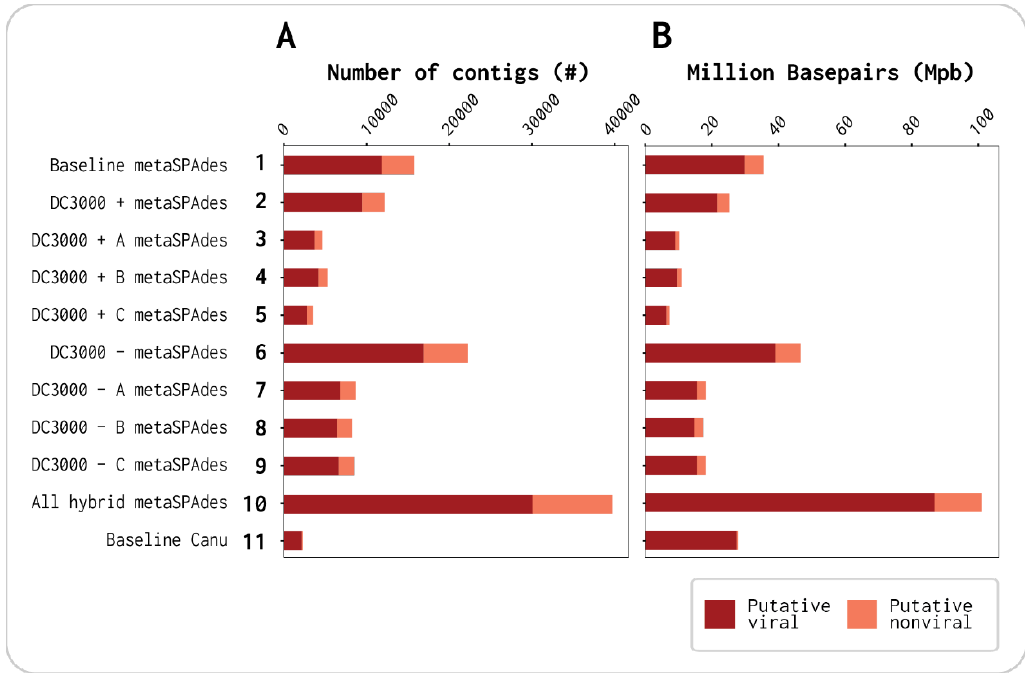
Figure 1. Identification of putative viral and putative nonviral contig count and million base pairs (Mbp) in each of the 11 assemblies by VirSorter2: ( A ) distribution of the number of putative viral vs. nonviral contigs; ( B ) distribution of putative viral vs. nonviral Mbp.